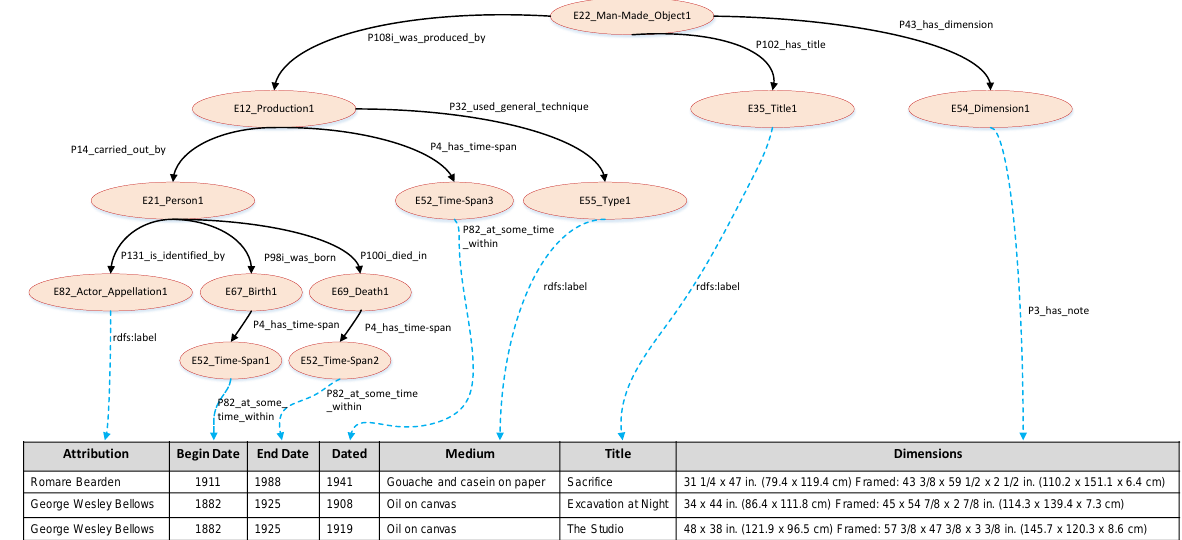
Figure 1. CB data source and its semantic